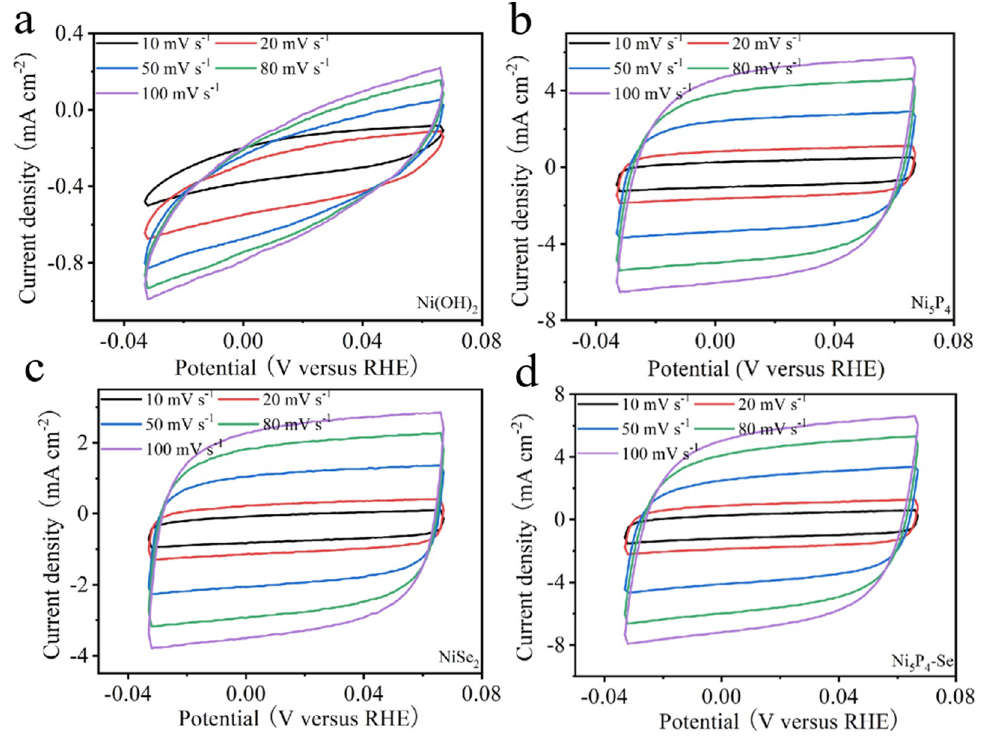
Figure 4. CV curves of Ni(OH) 2 ( a ), Ni 5 P 4 ( b ), NiSe 2 ( c ), Ni 5 P 4 − Se ( d ).